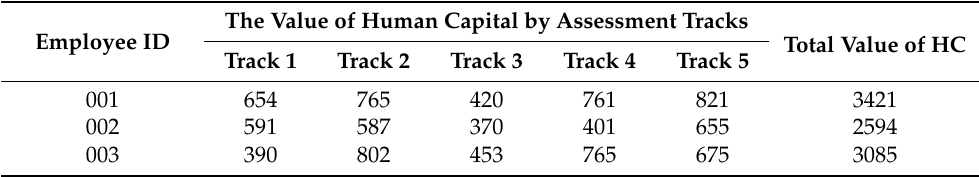
Table 7. Human capital assessment results in the department of contracts support. Employee